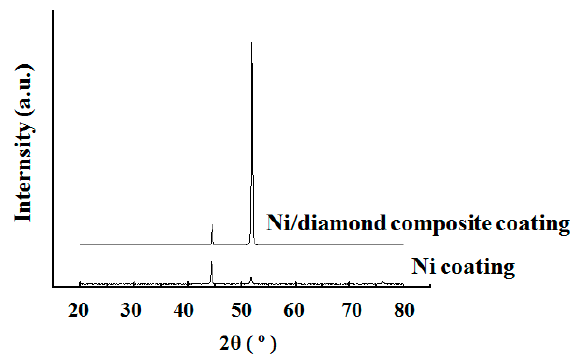
Figure 16. XRD spectra of the Ni/nanodiamond composite and Ni coatings.